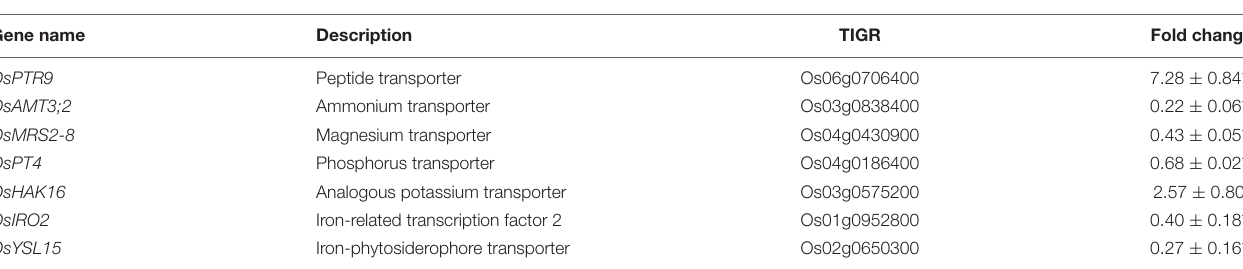
FIGURE 7 | The effect of P. oryzae on nutrient content in rice seedling tissues. (A) The nutrient content in shoots. (B) The nutrient content in roots. Independent-samples t -test analyzed data. The symbols * and ** indicate significant differences at P < 0.05 and P < 0.01, respectively. TABLE 2 | The relative expression of genes related to plant nutrient element absorption.